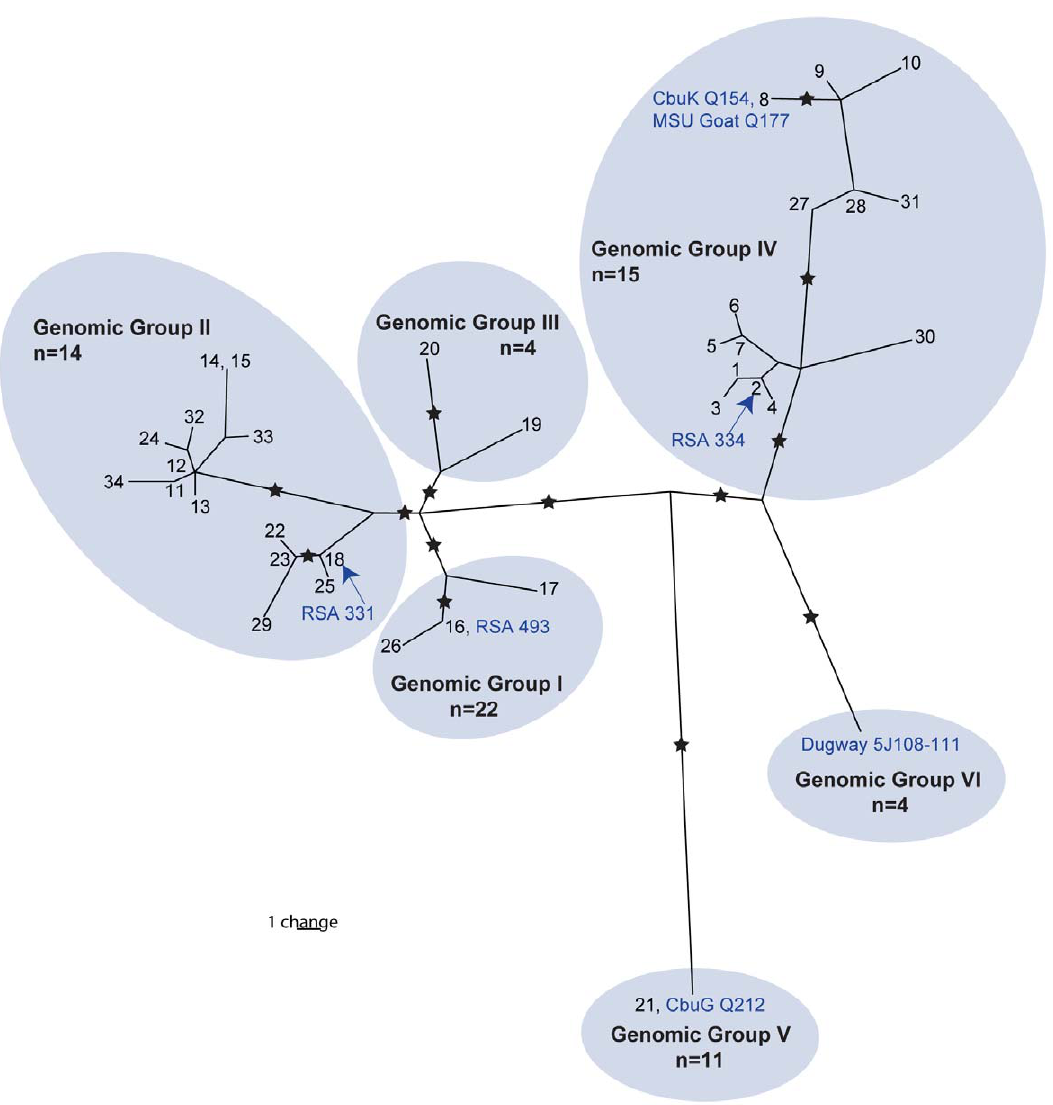
Figure 1. Maximum parsimony phylogeny of 35 MST genotypes for Coxiellaburnetii . This phylogenetic tree has a homoplasy index of 0.0909 and was drawn as described in the methods and results using the 112 polymorphisms listed in Table S1. The 34 MST genotypes and their positions on the phylogeny are given along with a novel MST genotype derived from in silico analysis of the whole genome sequence Dugway 5J108–111. The remaining six whole genome sequences are shown in blue text alongside their corresponding MST genotype as determined by in silico analysis, however analyses of MSU Goat and African Q revealed alleles at only 9 of 10 loci, therefore they are assigned to their most likely MST genotype. Our alignments showed no differences between MST genotypes 14 and 15. Stars indicate the 14 branches that were targeted for assay development. Our predicted genomic groups based on Hendrix et al. [10] are highlighted along with the total number of samples (n) from our study that genotyped into these